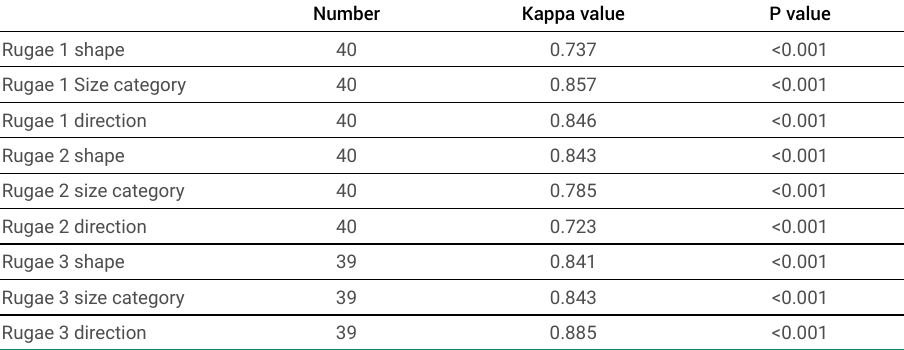
Table 3. Kappa values for inter-examiner reliability.